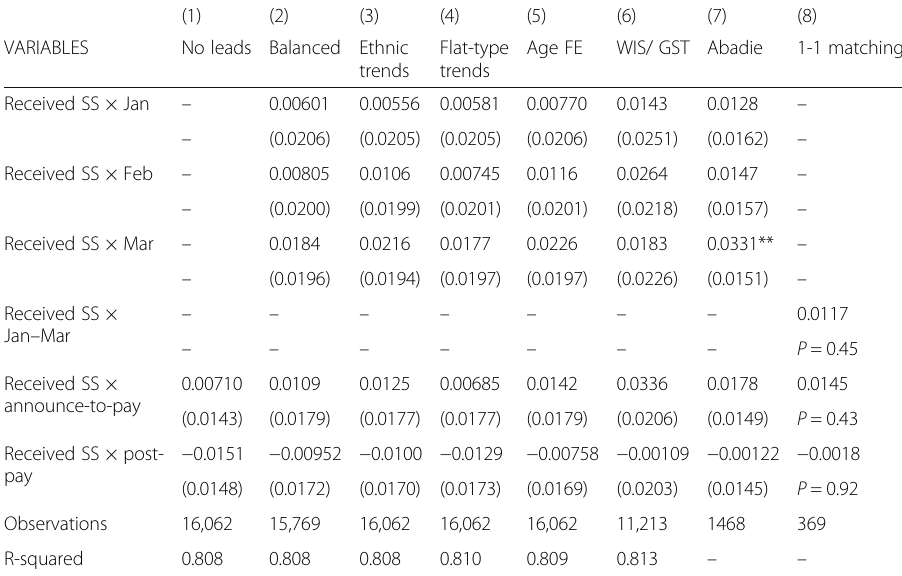
Table 11 Robustness check for impact of receiving SSS payouts on receiving income from